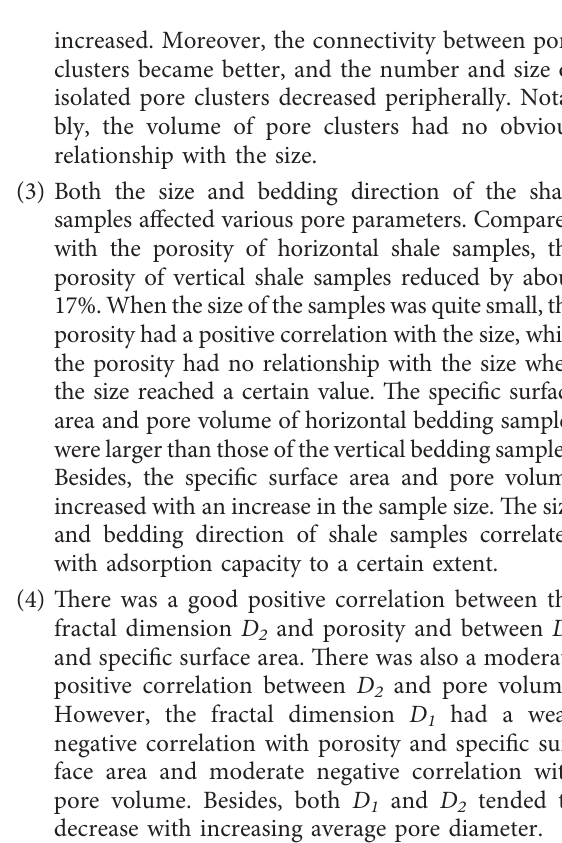
Figure 11: The relationships between fractal dimension ( D (d) average pore